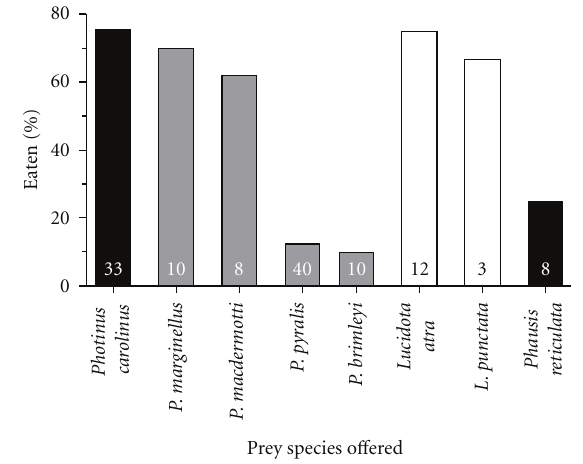
Figure 3: Di ff erences among firefly taxa in the percentage of individuals consumed by predatory Photuris femmes fatales during 24h laboratory trials. Sample sizes (number of trials) are shown within bars, and shading indicates the activity period of each species (black: fully nocturnal; grey: dusk-active; white: